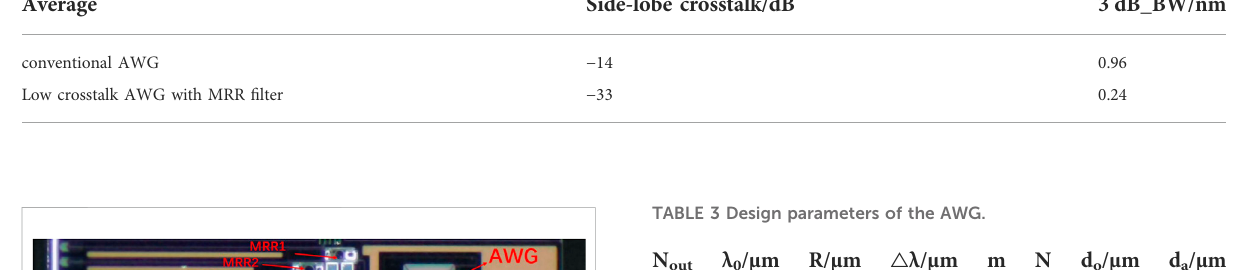
TABLE 1 The simulated performance of conventional AWG and low crosstalk AWG.